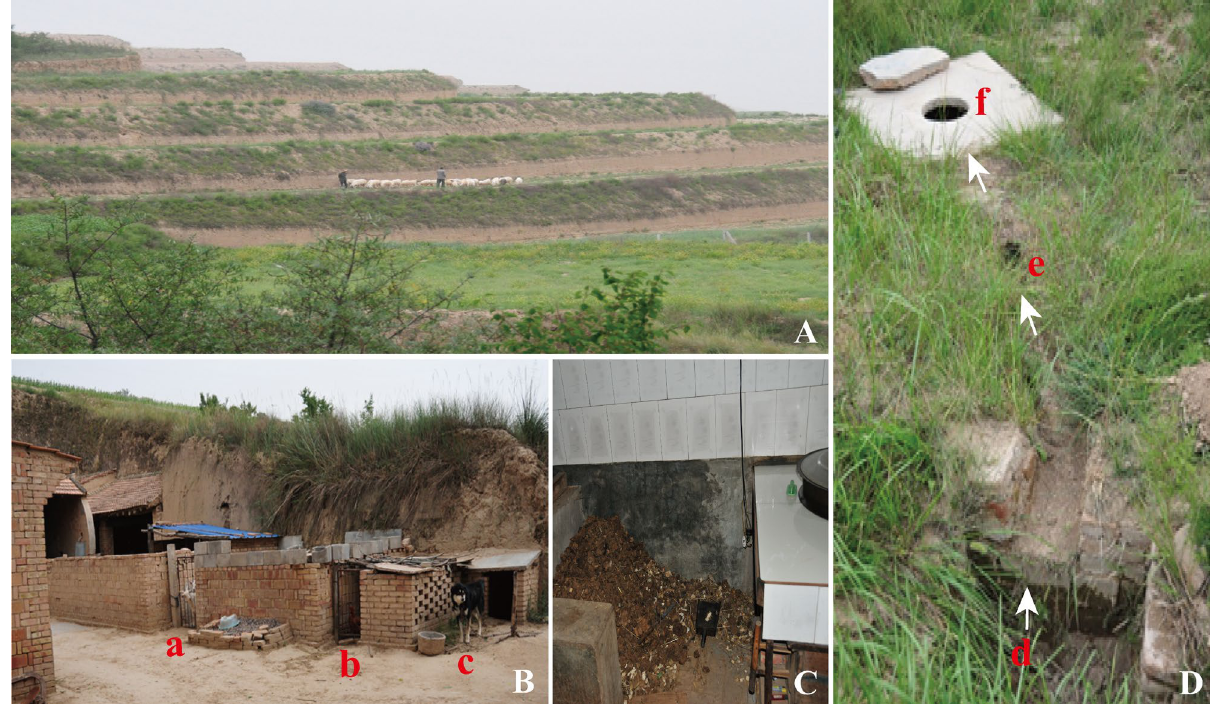
Figure 2. Households and transmission environment of echinococcosis in Xiaonangou township. ( A ) Grazing sheep in grassland, ( B ) Stalls rearing domestic animals adjacent to the house for (a) sheep, (b) chicken and (c) dog, ( C ) Cow dung stored in corner of kitchen as fuel supply for cooking, ( D ) Water cellar for collection of rainfall as drinking water for farmers and animals (d) inlet of rainfall collection pool for sedimentation, (e) water flow channel, (f) an opening of reservoir well for water uptake. The arrows indicate the water flow direction downwards from a higher position (d) through (e) to reservoir well (f) when the water overfills the collection